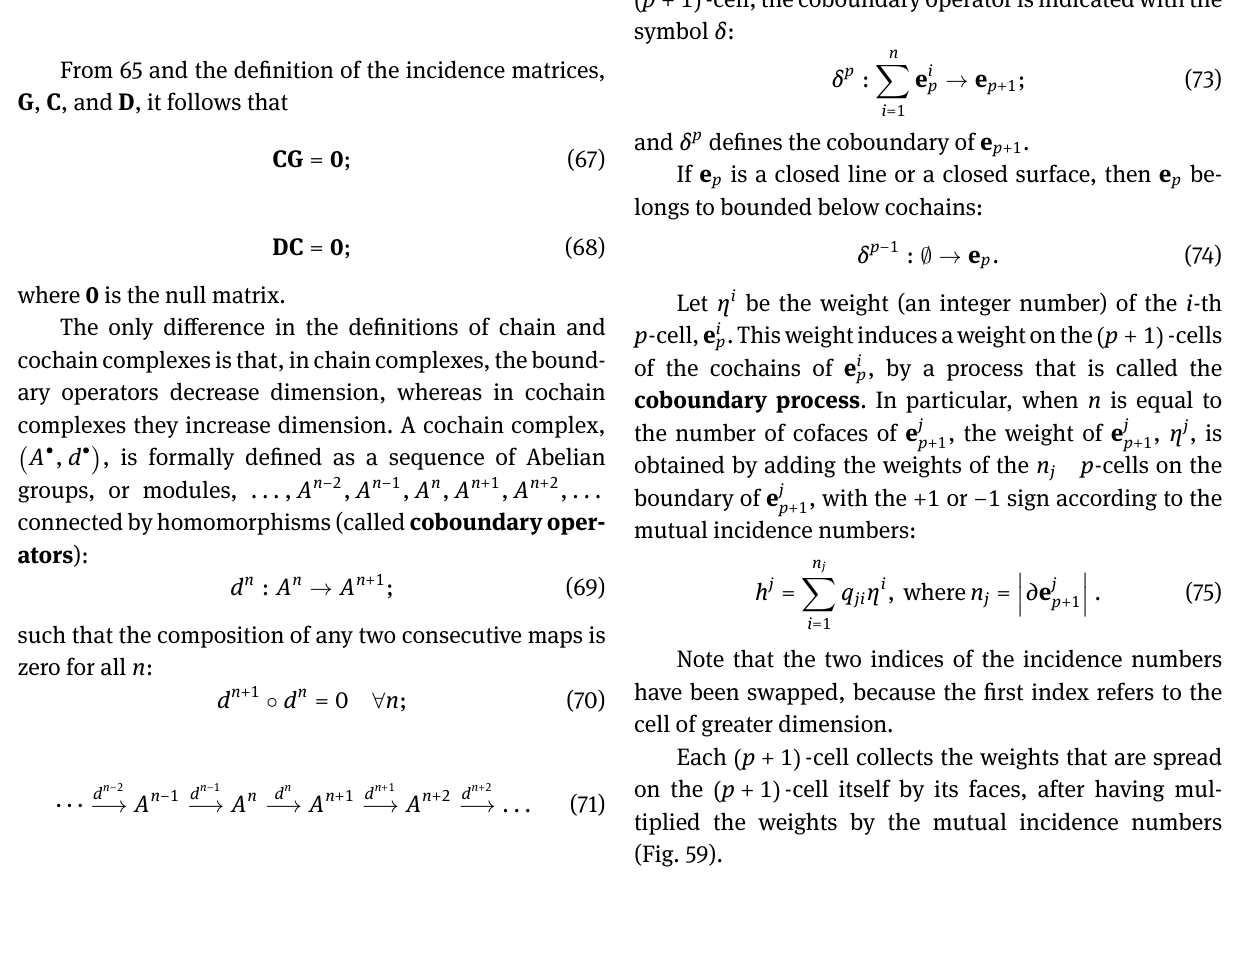
Figure 58: Spreading of the weight of one p -cell on the faces of its faces.